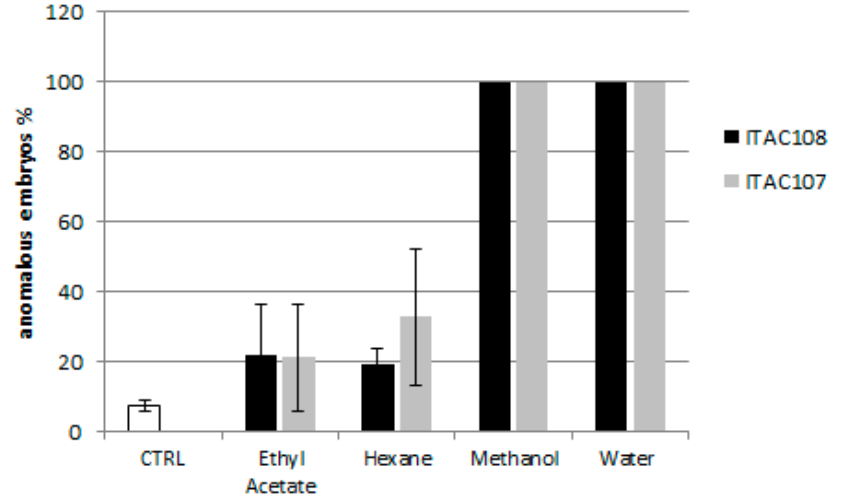
Figure 2. Percentage of anomalous sea urchin embryos after 24 h of treatment with cyanobacterial extracts.